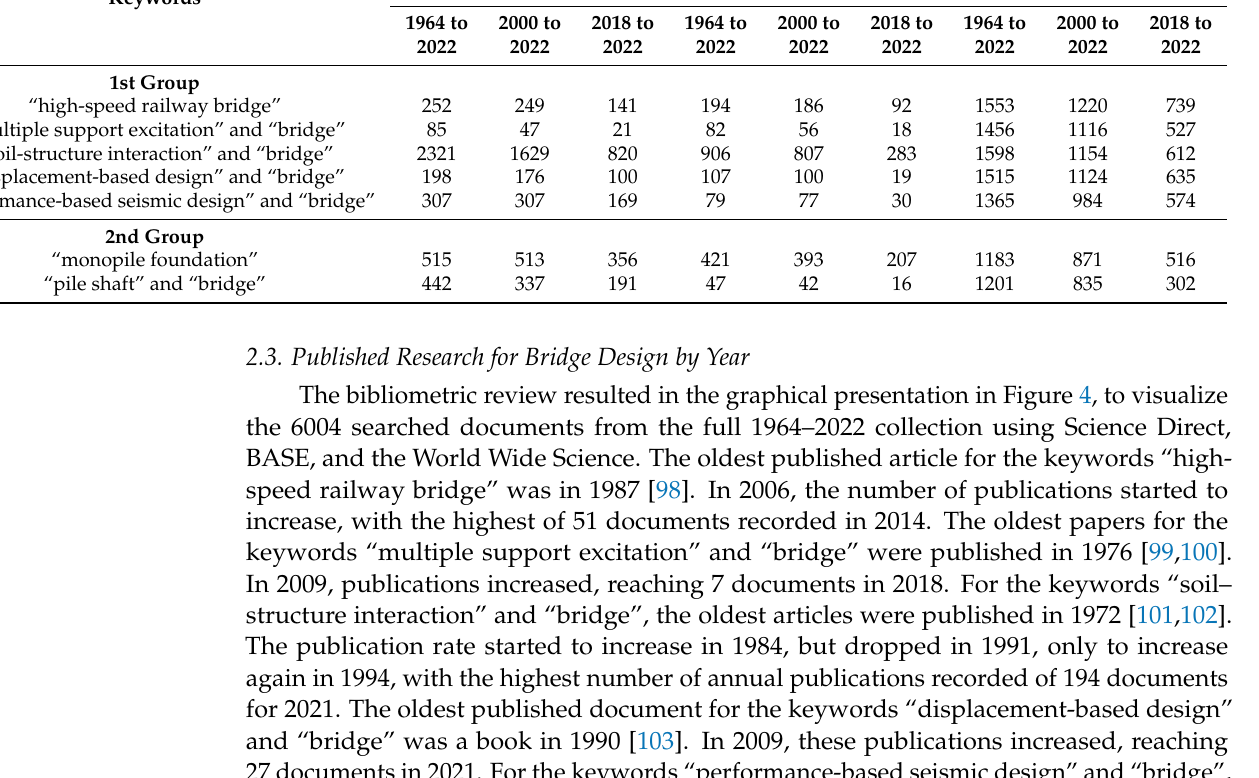
Table 6. Collected electronic data from multiple search systems.